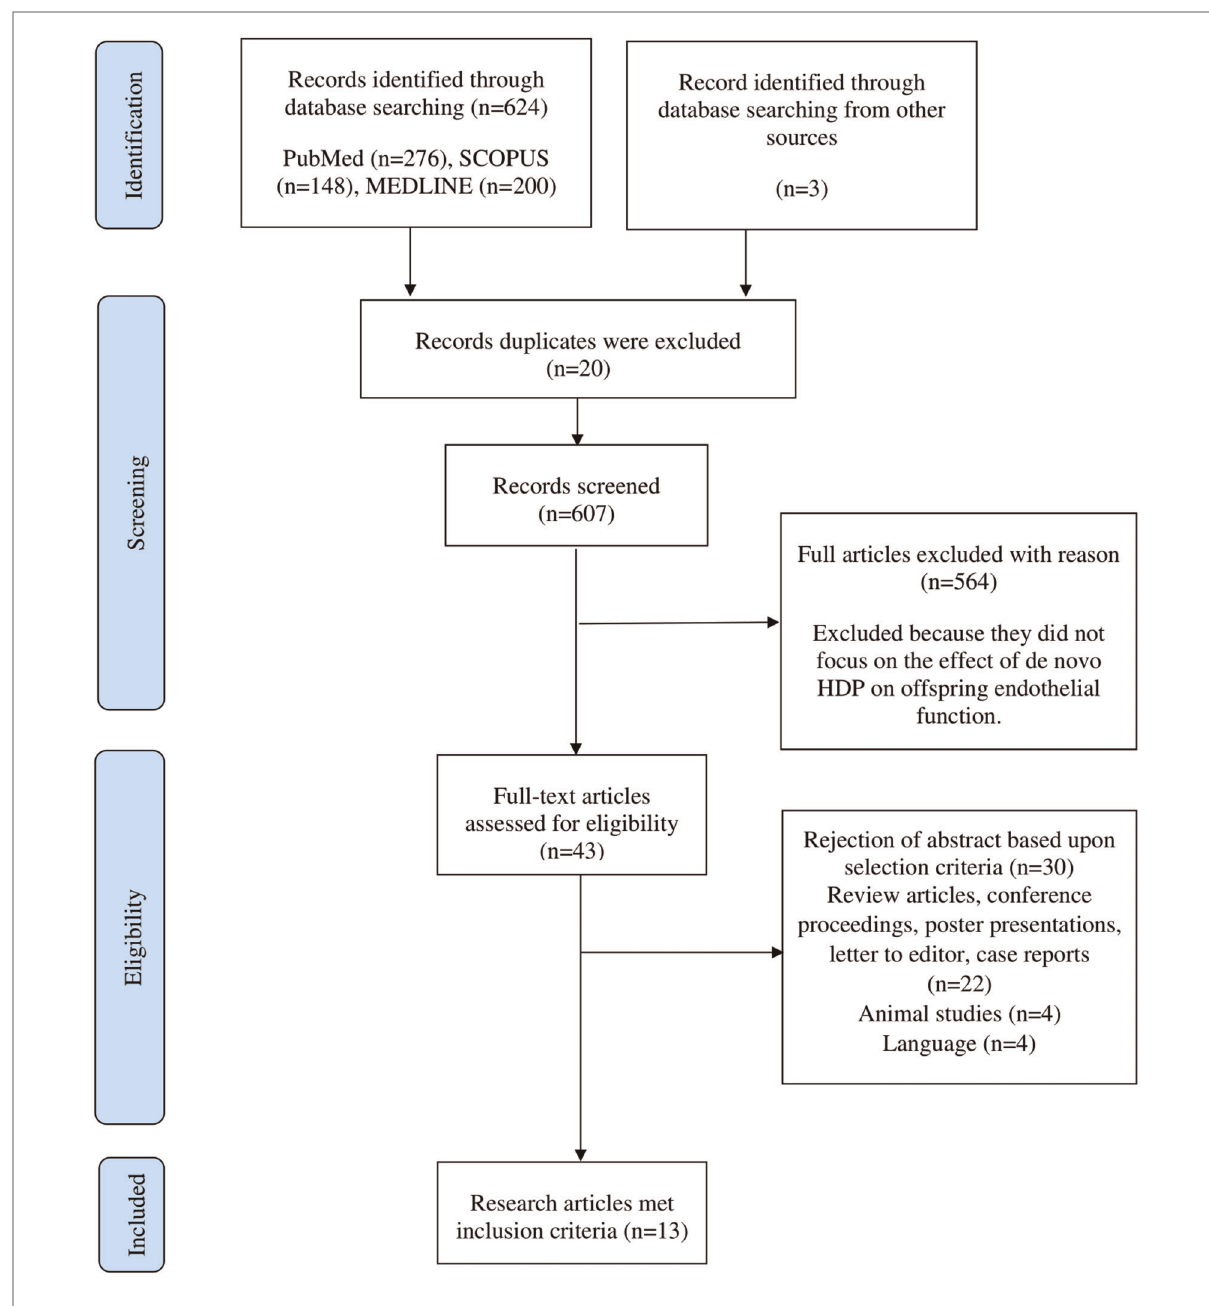
FIGURE 1 Summary of the steps involved in article selection process according to PRISMA